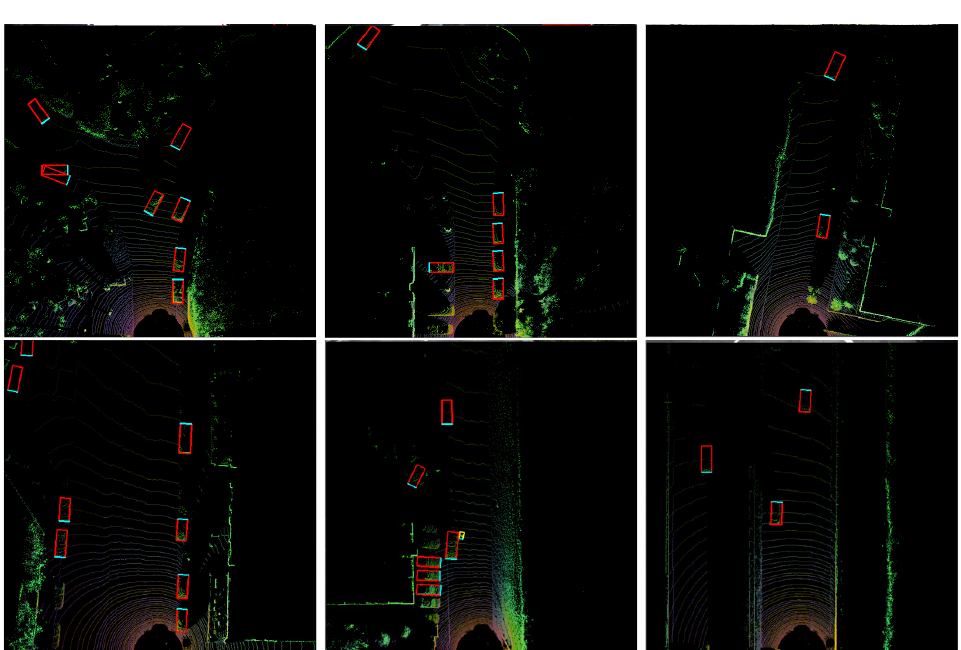
Figure 10. BirdNet+ algorithm detection results.